Question: What style of plot is this figure drawn as?
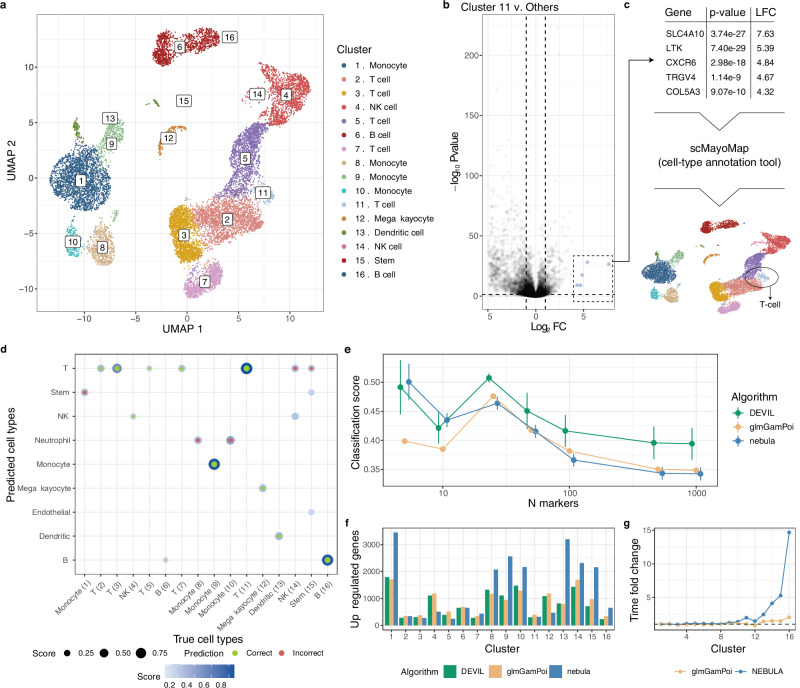
Answer: scatter